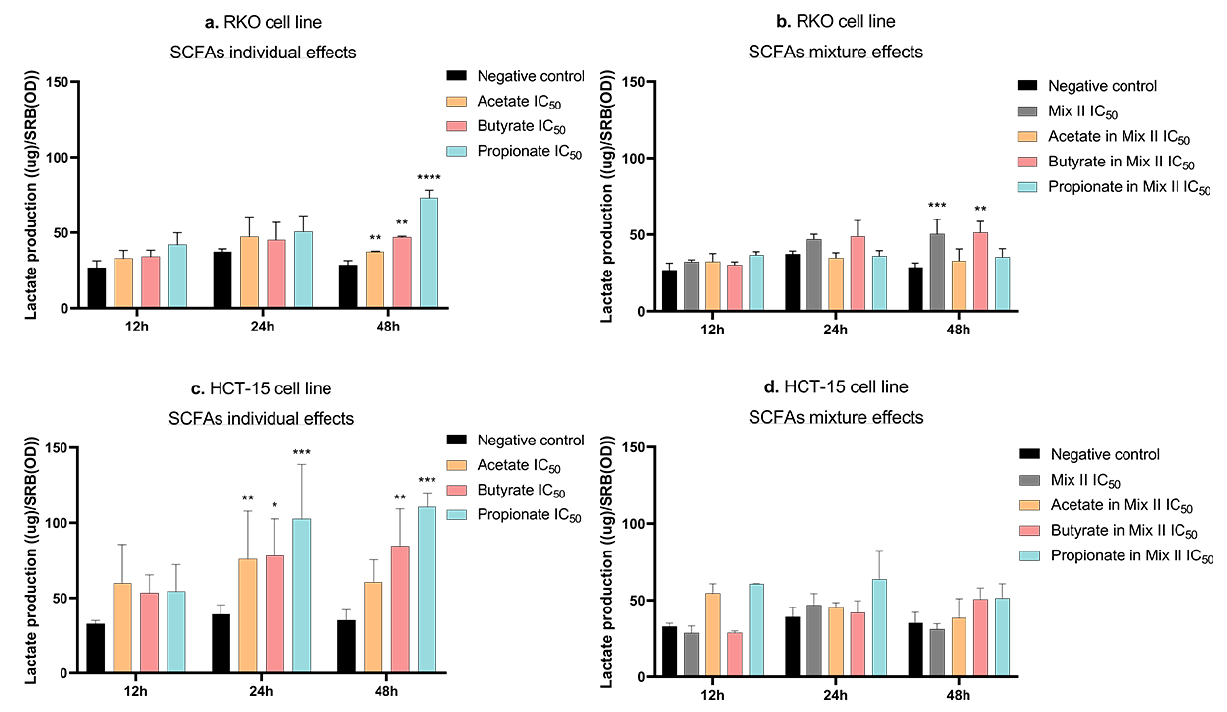
Figure 6. Energetic metabolism effects induced by SCFAs, individually or in mixture, in CRC cells. ( a – d ) Lactate-production quantification using the Lactate LO-POD enzymatic colorimetric kit from Spinreact in CRC cells treated with each SCFA, individually or in mixture, for 48 h. ( a ) RKO cells were incubated with the IC 50 of each SCFA (81.04 mM of acetate, 10.84 mM of butyrate, 32.25 mM of propionate). ( b ) RKO cells were incubated with the IC 50 of the mixture II, as well as the correspondent concentrations of each SCFA in that mixture (47.61 mM of Mix II containing 28.57 mM of acetate, 7.14 mM of butyrate, and 11.90 mM of propionate). ( c ) HCT-15 cells were incubated with the IC 50 of the mixture II, as well as the correspondent concentrations of each SCFA in that mixture (13.67 mM of Mix II containing 8.20 mM of acetate, 2.05 mM of butyrate, and 3.42 mM of propionate). Cells were incubated with fresh complete medium as analysis was performed using Two-Way ANOVA (p-value 0.0332 (*), 0.0021 (**) and 0.0002 (***)).